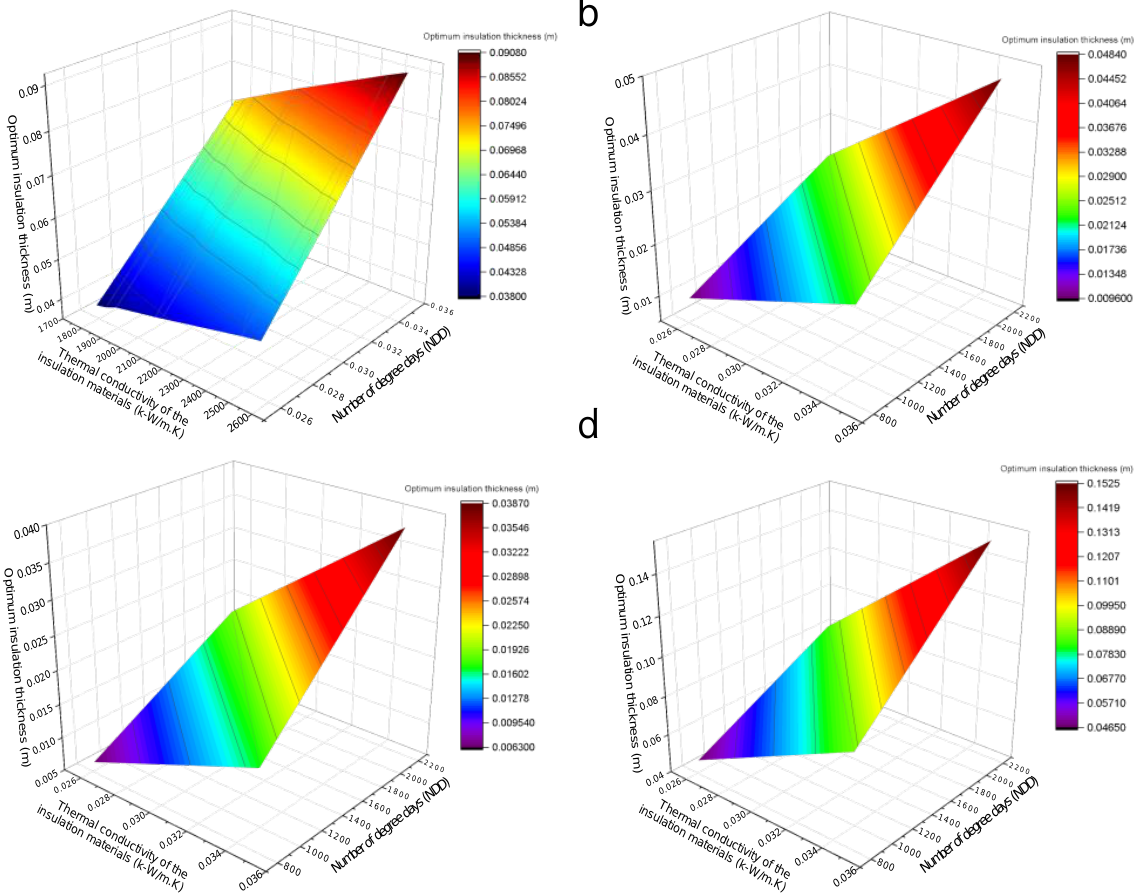
Figure 5. Optimal insulation thickness and k-NDD values: ( a ) electricity; ( b ) natural gas; ( c ) coal; ( d ) diesel. Table 6. Developed model regression constants.